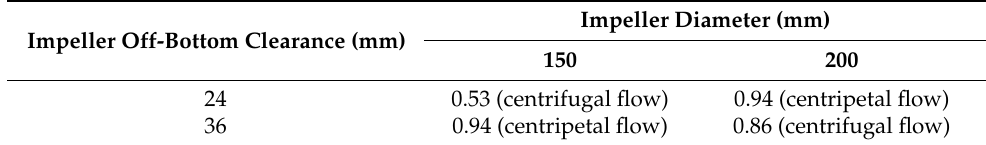
Table 5. Maximum axial fluctuating RMS velocity (m·s −1 ) with the related impeller diameter and its off-bottom clearance.